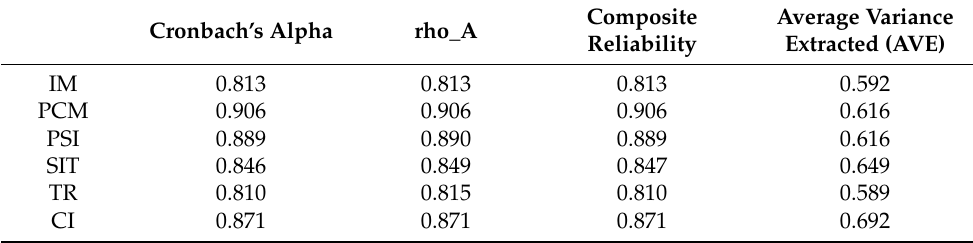
Table 3. Reliability and convergent